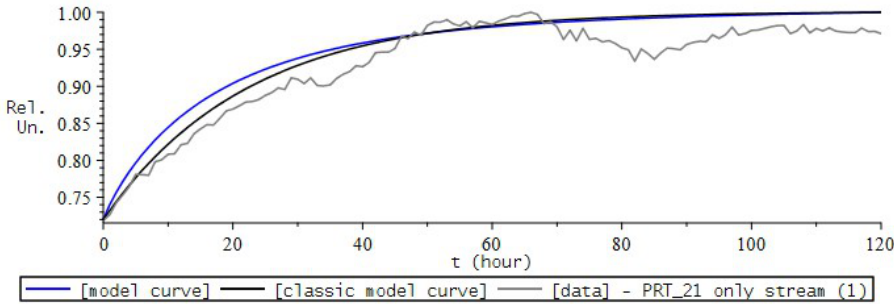
Figure 26. Correlation coefficients: 96.5% for the proposed (17) model (blue), and 97.1% for the classic (15) model (black).